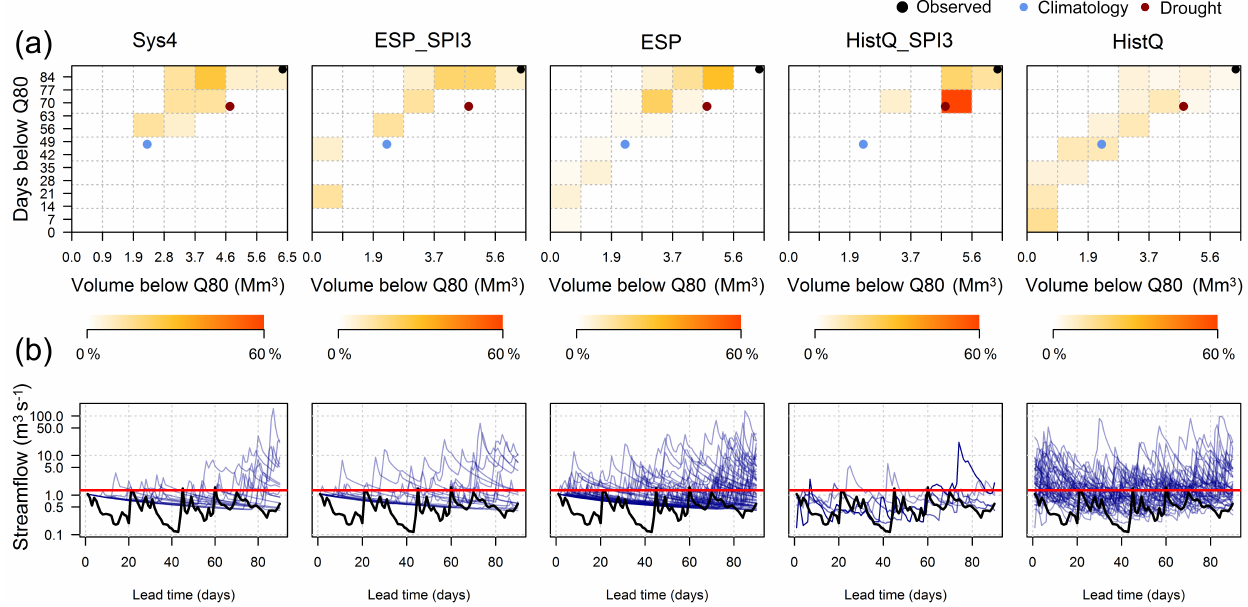
Figure 11. Risk graphs presenting the probabilities of deficit duration versus deficit volume based on the 80th exceedance percentile (upper row) and corresponding hydrographs (lower row). The maximum probability varies with the ensemble and the situation and is indicated in the colour scale. The black point corresponds to the observation, the dark red dot to the drought of 1976 and the blue dot to the mean duration and deficit volume observed in past streamflows. Each column corresponds to one of the five ensemble forecasts. Forecasts were issued for the Azergues at Lozanne (catchment 5) on 1 July 2003 for the next 90